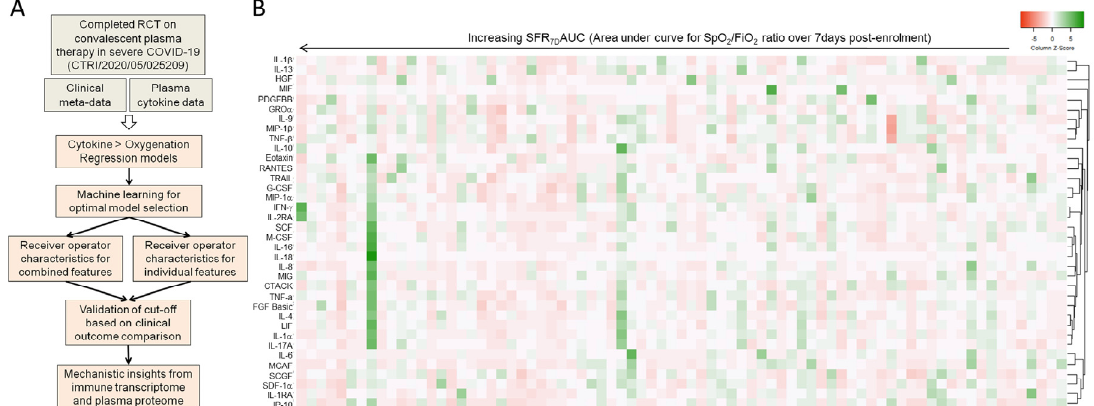
Figure 1. Circulating cytokines and blood oxygenation in severe COVID-19 patients. ( A ) Experi- mental schema for the study. ( B ) Correlation (Pearson) clustering of plasma abundance of cytokines shown in order of increasing blood oxygenation (represented by area under curve of the SpO2/FiO2 ratio kinetics over 7 days following recruitment.